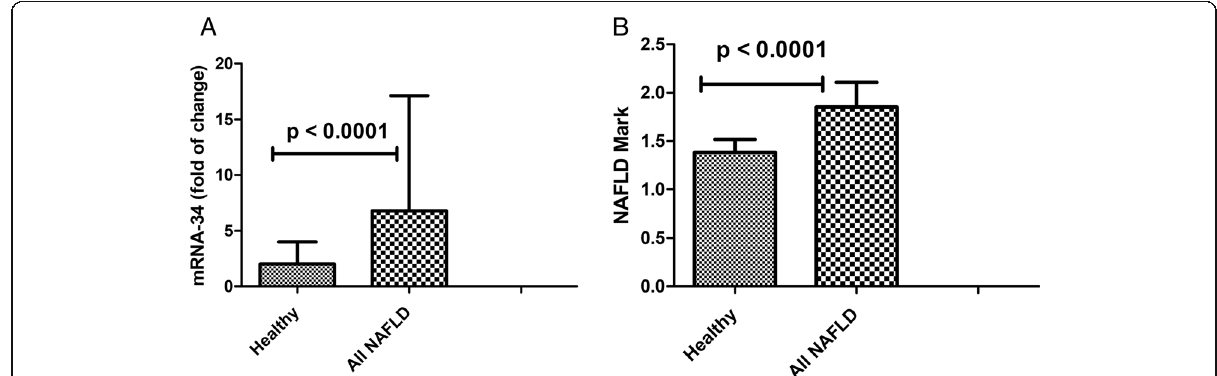
Fig. 1 Level of miRNA-34 and NAFLD mark. A Level of miRNA-34 in healthy and NAFLD groups. B Level of NAFLD mark in healthy and NAFLD groups. Error bar is